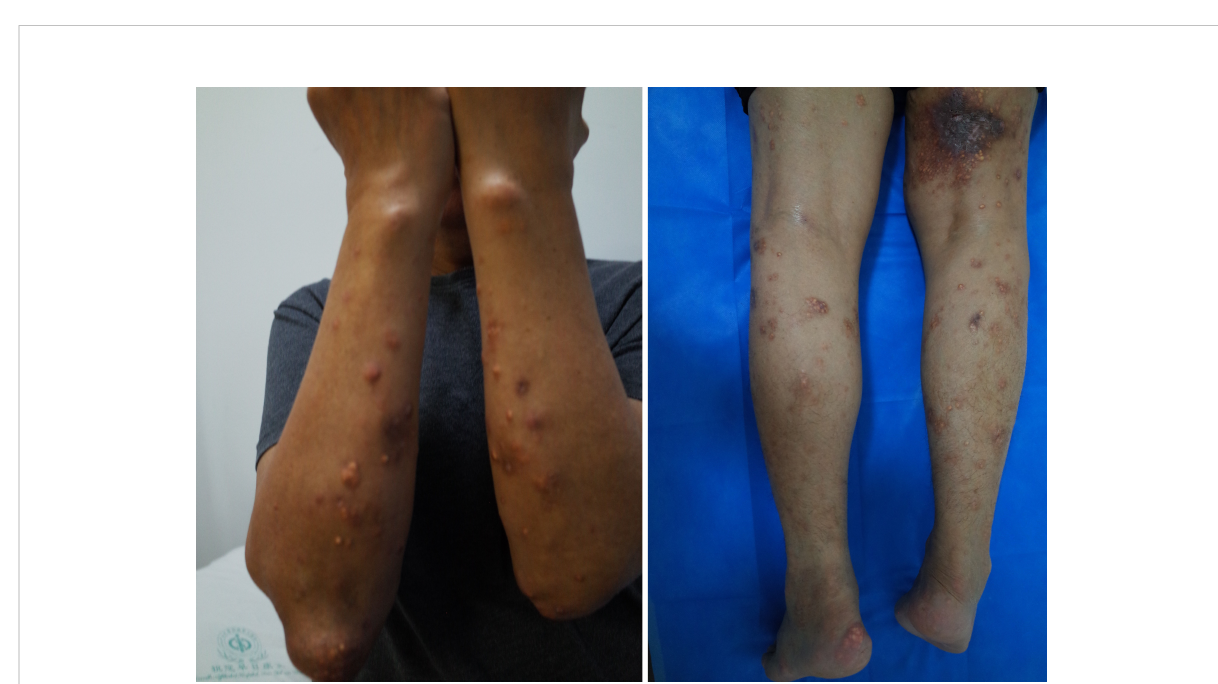
FIGURE 1 Tophi were found to have precipitated in the subcutaneous tissue and skin ulcerations were observed. The subcutaneous tophi deposits were similar to papules on the forearms, shins, and inner thighs and contained a chalk-like substance. Subcutaneous gout on the thigh also resulted in skin